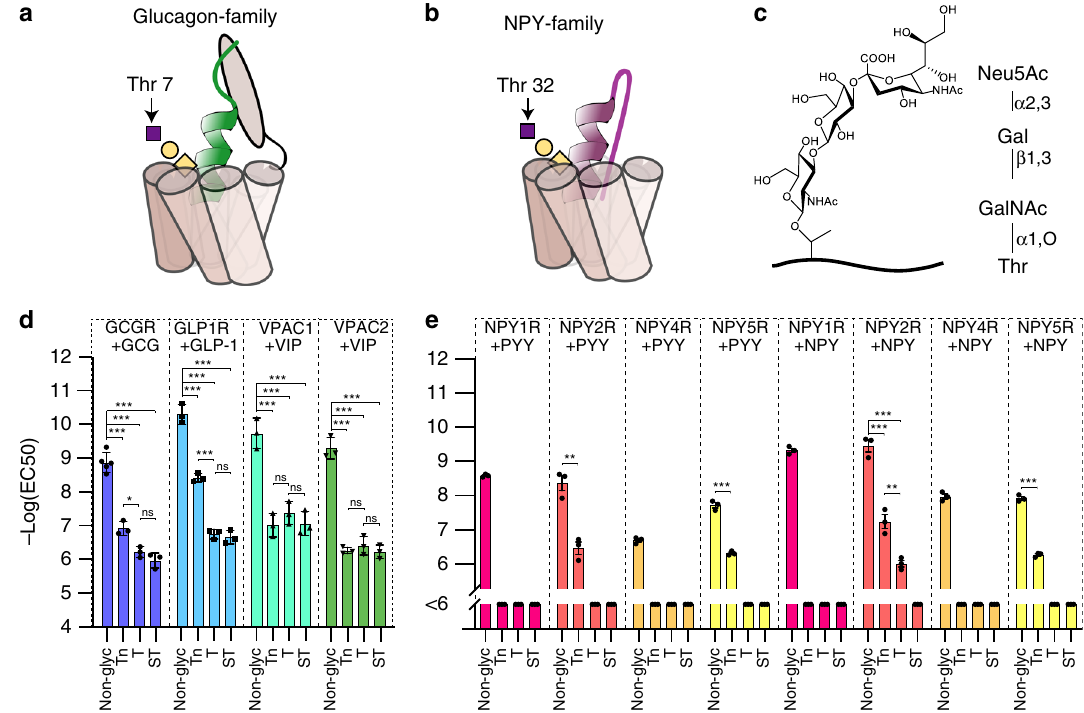
Fig. 4 Functional analysis of O-glycans within the receptor-binding region of peptide hormones. a Schematic depiction of the Thr 7 O-glycan positioned within the receptor-binding domain of the glucagon hormone family (see Supplementary Fig. 7e). b Schematic depiction of the Thr 32 O-glycan positioned within the receptor-binding domain of the NPY hormone family 38 . c Structural representation of the sialyl-T O-glycan. d Potencies (Log 10 (EC 50 )) of glycosylated GCG, VIP, and GLP-1 determined in cell-based receptor activation assays ( n = 3 independent experiments in duplicate determinations for all groups, except non-glyc. GCG where n = 5). e Potencies of NPY and PYY in their Thr 32 glycoforms determined and shown as in d ( n = 3 for all groups). All error bars represent mean ± S.E.M. Two-tailed one-way ANOVA (Tukey ’ s post hoc test) was performed in d and e except for comparisons within NPY2R + PYY-; NPY5R + PYY-, and NPY5R + NPY-assays in e where two-tailed Student ’ s t -test was performed. ns not signi fi cant; * p < 0.05; ** p < 0.01; *** p < 0.001 (all signi fi cant p -values are <0.0001 except d GCGR-Tn/GCGR-T p = 0.0149; e NPY2R-PYY-Non-glyc/NPY2R-PYY-Tn p = 0.0027; NPY2R-NPY/NPY2R- NPY-Tn p = 0.0002; NPY2R-NPY-Tn/NPY2R-NPY-T p = 0.0046). Source data for d and e are provided as a Source data fi